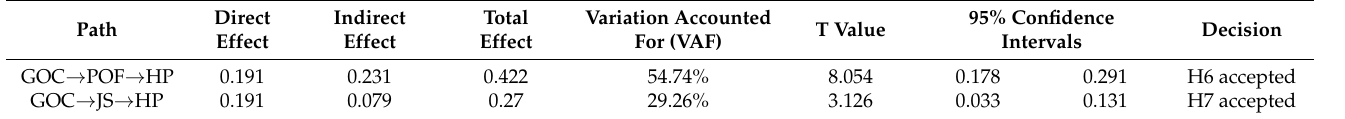
Table 7. Mediation